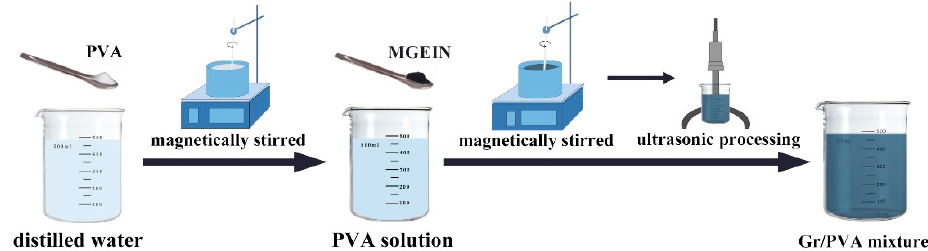
Figure 1. The preparation method of Gr/PVA impregnation mixture. The impregnating mixture used for each veneer was 60 g, the specific formulations of the Gr/PVA impregnating mixture were shown in Table